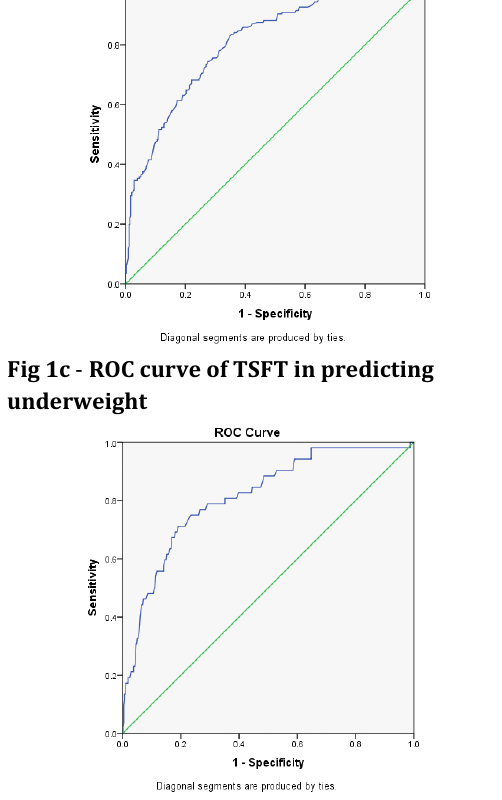
Fig 1d - ROC curve of TSFT in predicting